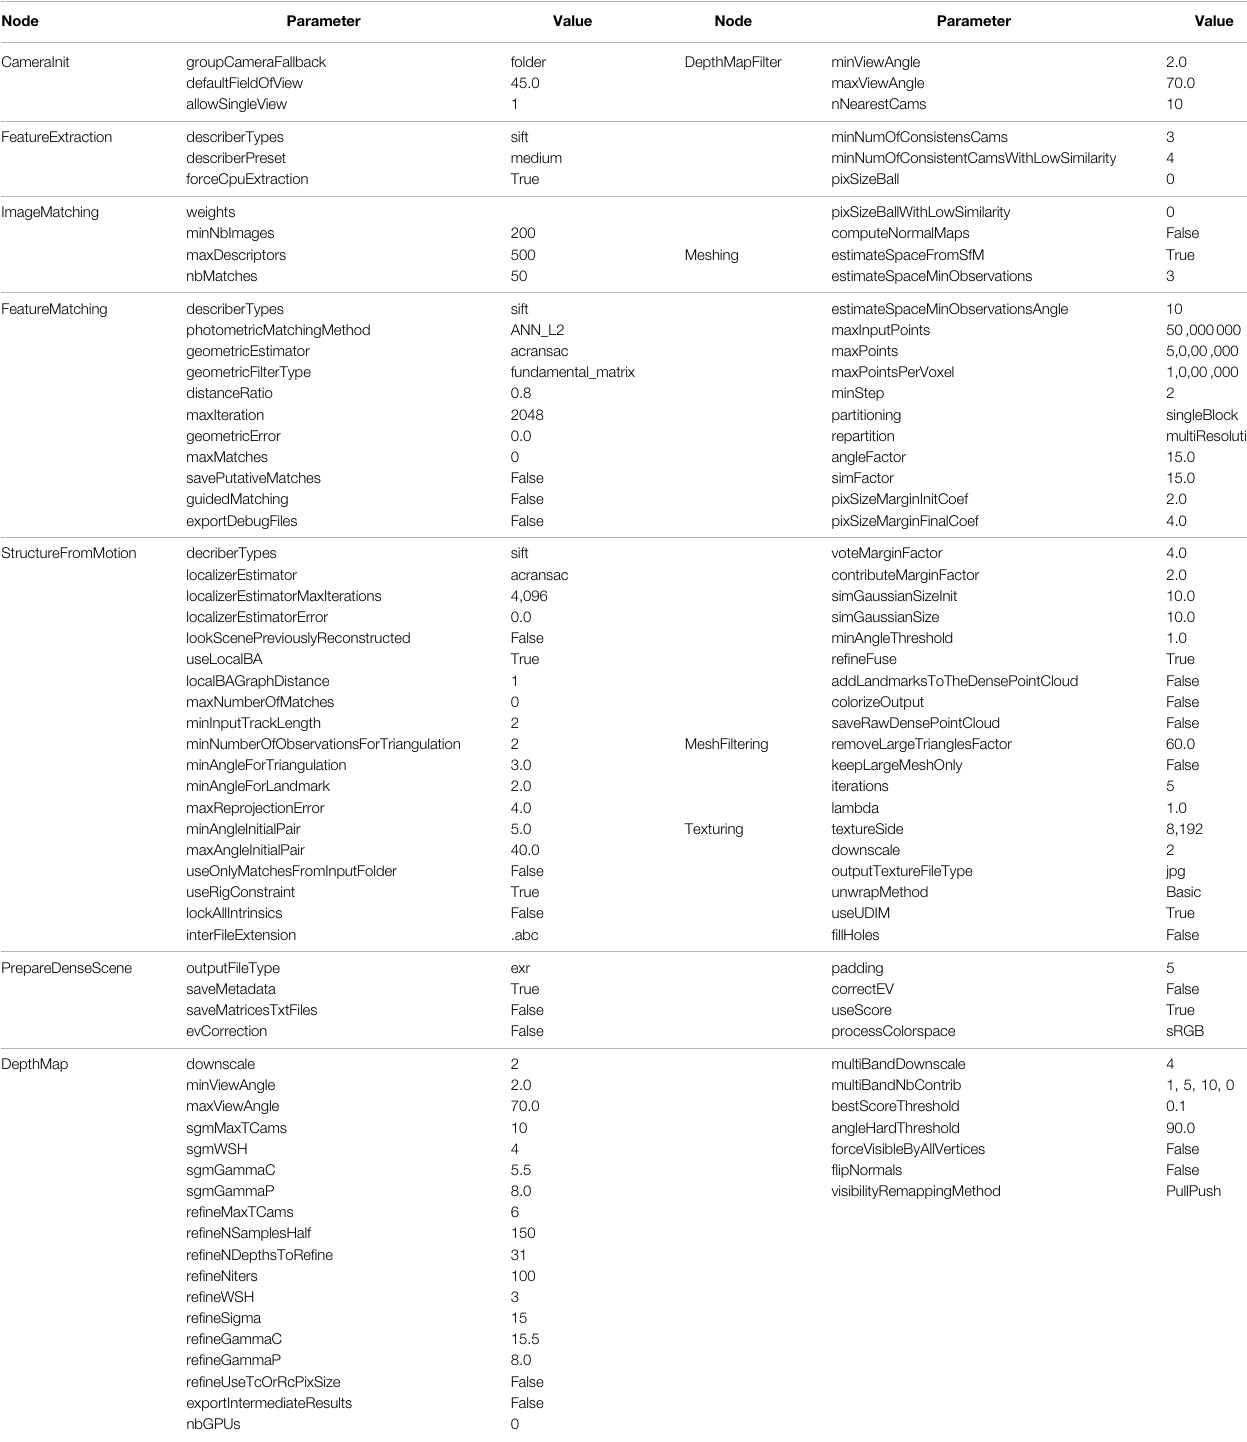
TABLE A1 | Mapping of the medium quality setting to AliceVision